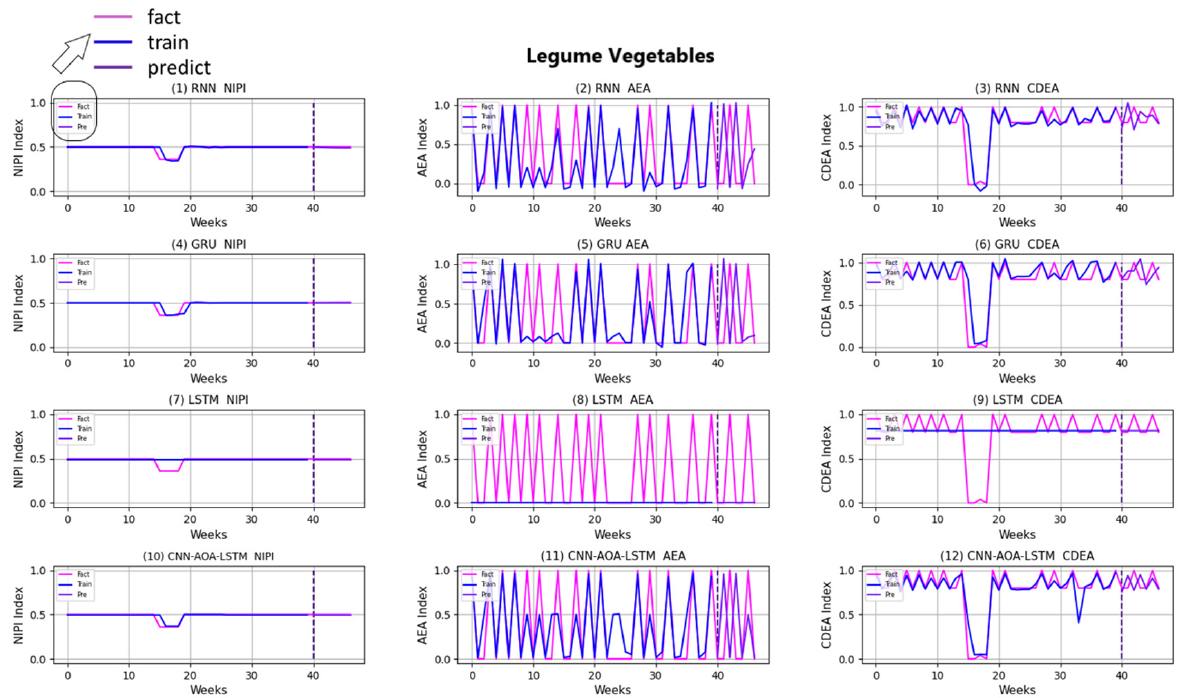
Figure 8. Prediction results of indexes of legume vegetables.